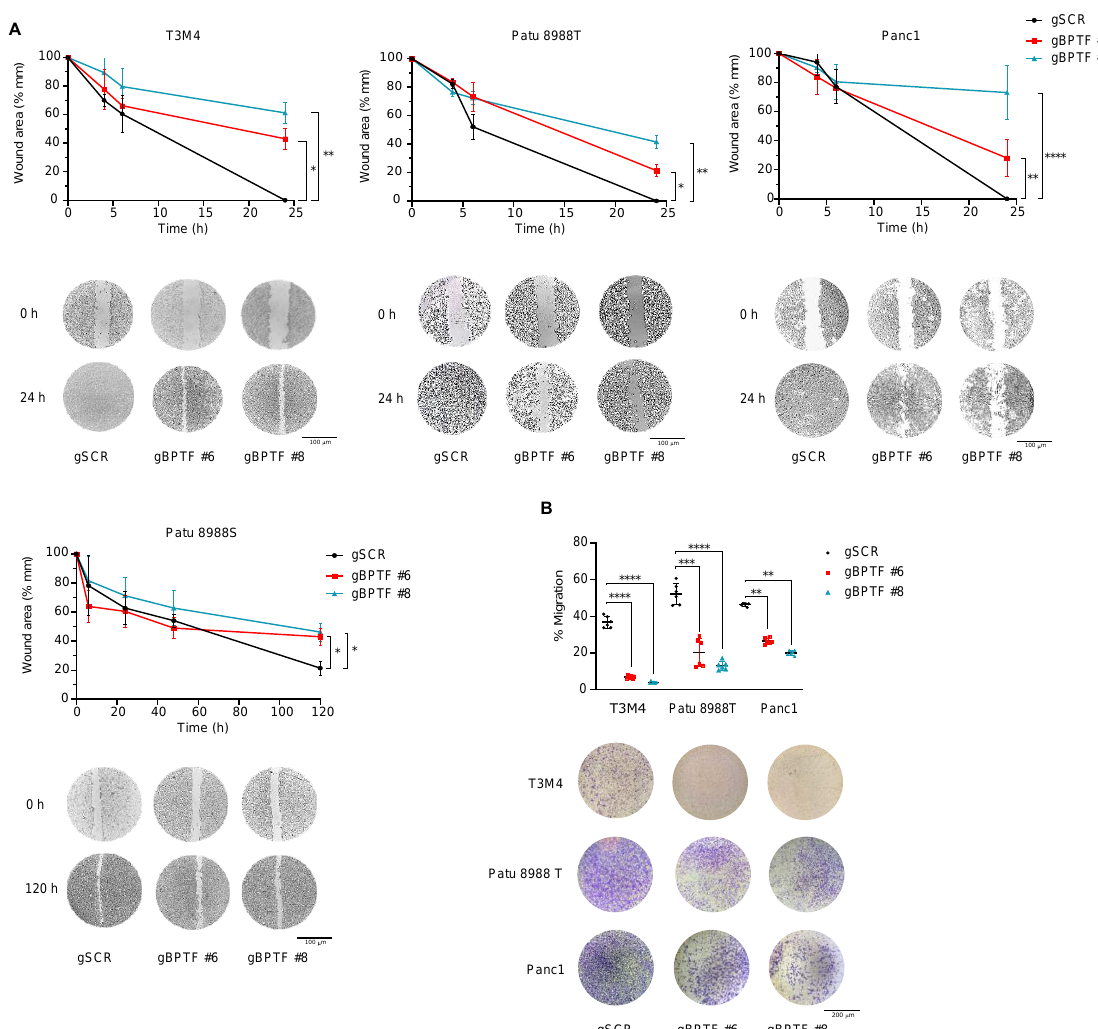
( B ) Proliferation and colony assay of BPTF-interfered cells compared to gSCR in T3M4 and Patu 8988T cell lines; n = 6. ( C ) Cell cycle assay by FACS of BPTF-interfered cells compared to gSCR in T3M4 and Patu 8988T cell line; n = 3. ( D ) Nude mice were subcutaneously implanted with either BPTF- interfered T3M4 cells (gBPTF #6 and gBPTF #8) or non-targeted (gSCR), and tumours were measured for 24 days; n = 8 and representative images of the different tumours. ( E ) Representative images of Ki67 immunohistochemistry and its quantification. Significance was considered for * p < 0.05, ** p < 0.01, *** p < 0.005, and **** p < 0.001, ns (not statistically significant). To assess the role of BPTF during cell migration, we downregulated BPTF levels either by CRISPRi or shRNA, and evaluated migration in wound-healing and transwell assays. We observed that BPTF downregulation in Patu 8988T, Panc1, and T3M4 clearly impaired cell migration, showing a delayed wound closing or migration through the transwell (Figure 3 and Supplementary Figure S4). Patu 8988S, which expressed the lowest BPTF levels (Supplementary Figure S1B), did not migrate in transwell assays. Together, these results strongly support the role of BPTF in cell migration.